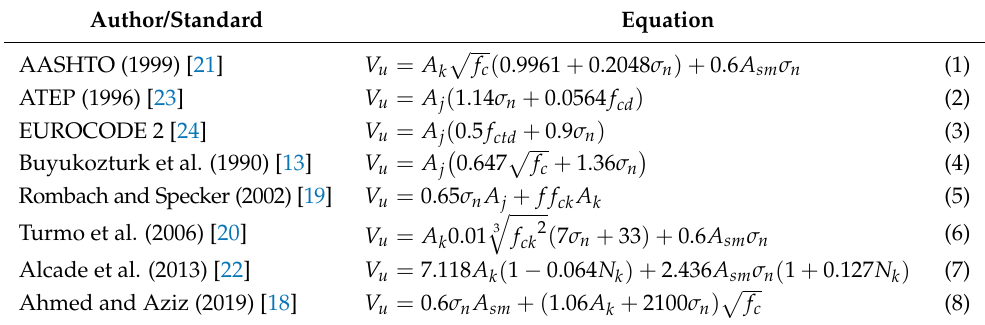
Table 1. Main equations for predicting the shear strength of dry joints.